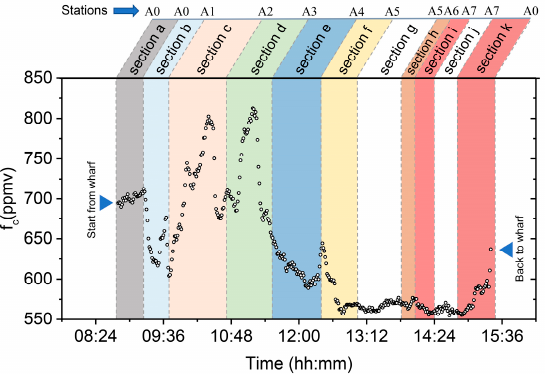
Figure 10. Underway measurement in Jiaozhou Bay. The As mark the measurement stations. For the subsequent analysis, the results were divided into many sections (a-k) with different colors.